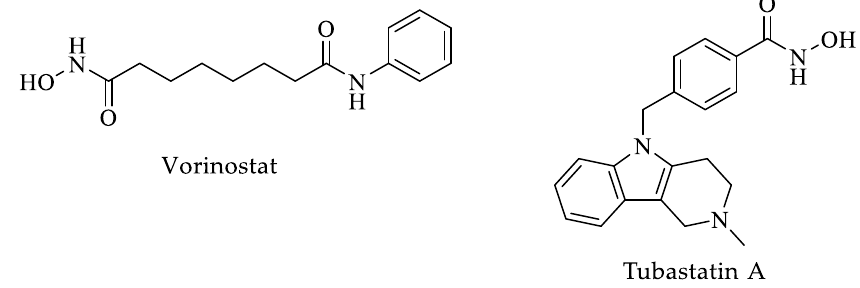
Figure 7. Pan-HDAC inhibitors as antileishmanial agents.